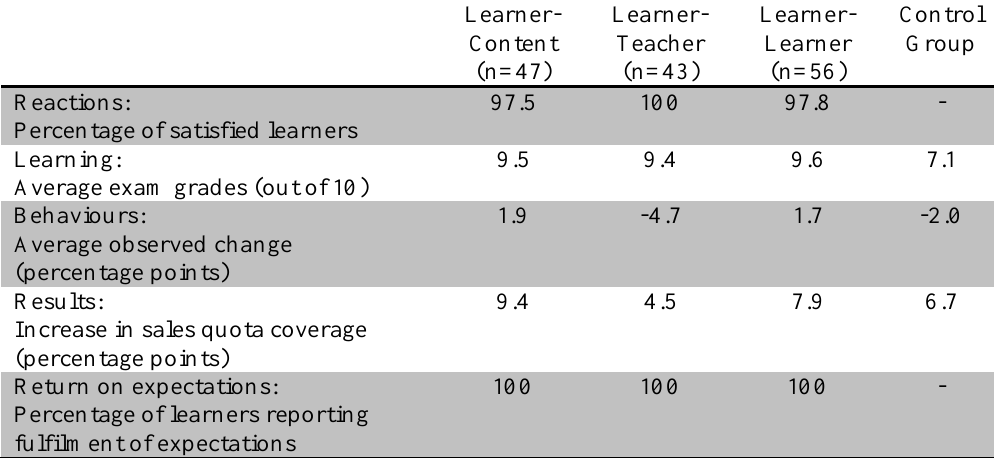
Comparison of the Effectiveness of each Course